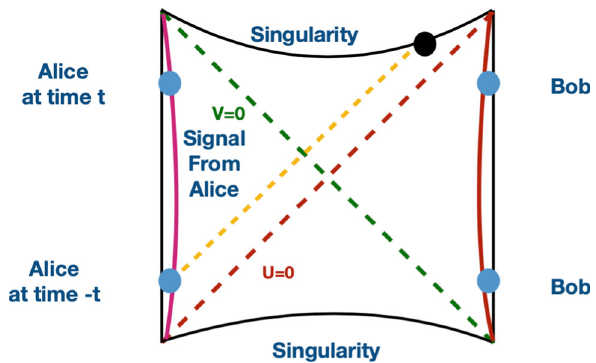
Fig. 3 Alice and Bob are accelerating near the left and right boundary. Alice sends a signal at time − t at the left boundary, (shown by yellow dashes). Instead of reaching Bob, it will be lost into the singularity as no light like trajectory can escape into one of exterior region from the other, bypassing the future interior